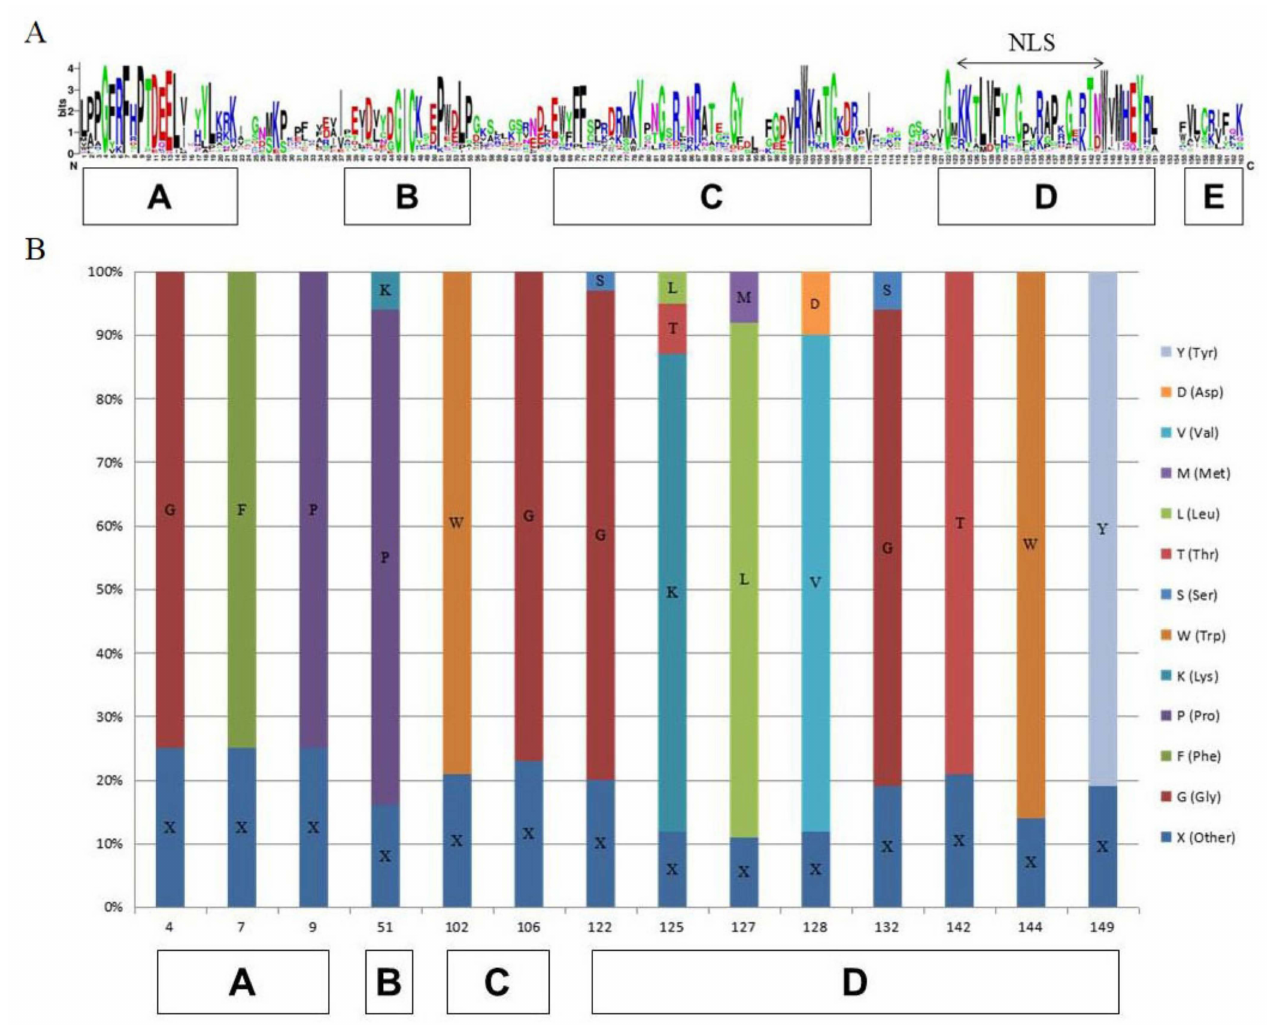
Figure 3. The sequence analysis of five subdomains in kiwifruit. ( A ) Sequence logo of five subdomains in kiwifruit. ( B ) The conserved amino acid distribution in five subdomains in kiwifruit. The histogram shows the percentage of amino acids at this